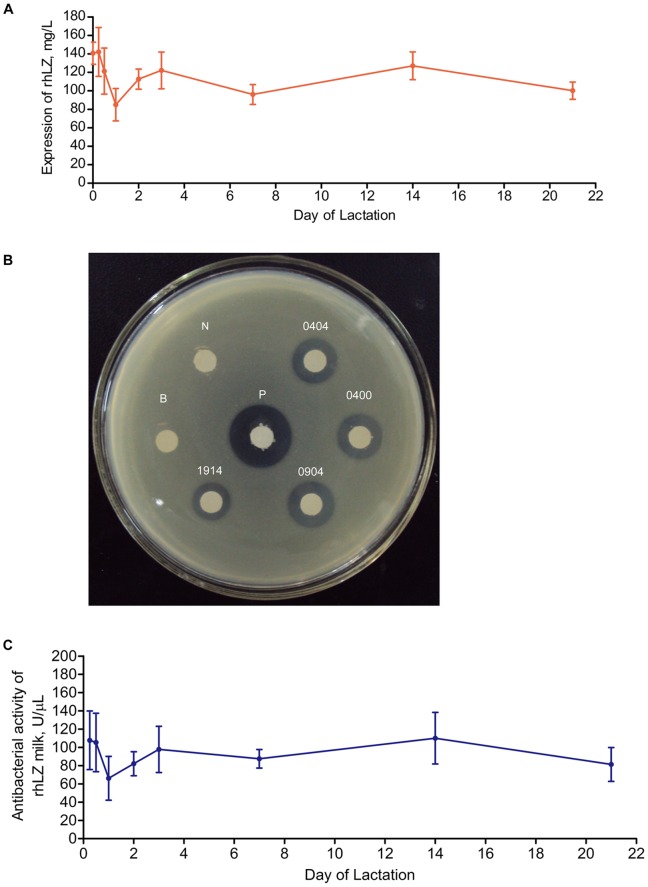
rhLZ expression level and enzymatic activity in the milk of transgenic pigs.(A) Human lysozyme concentrations in mammary secretions of first-parity transgenic gilts. Values are presented as means ± standard deviations. n = 5 gilts at each time point. (B) The gel diffusion assay for lytic activity of rHLZ milk against Micrococcus lysodeikticus. The small white circles are 6-mm quantitative filter papers spotted with 6 µL of 1∶3 diluted milk samples. Transparent zones around the quantitative filter papers indicate bacterial lysis. P, commercial hLZ (1 µg); B, sterile water; N, milk from non-transgenic pig; Milk samples nos. 0404, 0400, 0904, and 1914 are from F1 transgenic pigs. (C) The turbidimetric assay for antibacterial activity of rhLZ milk during lactation. Values are presented as means ± standard deviations. n = 5 gilts at each time point.